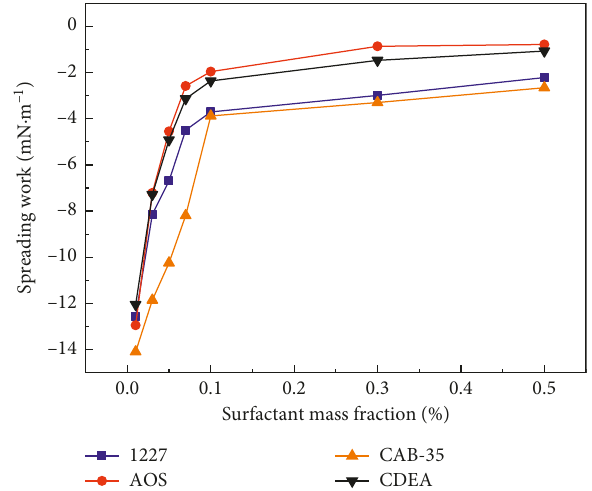
Figure 6: The adhesion works of the surfactant solutions on the coal dust surface at the different concentrations.